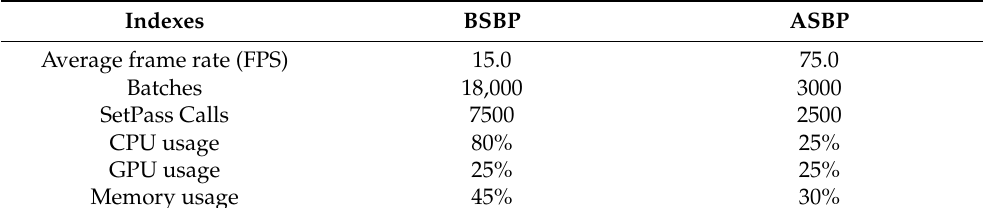
Table 1. Comparison specification of performance parameters before and after static batch processing.